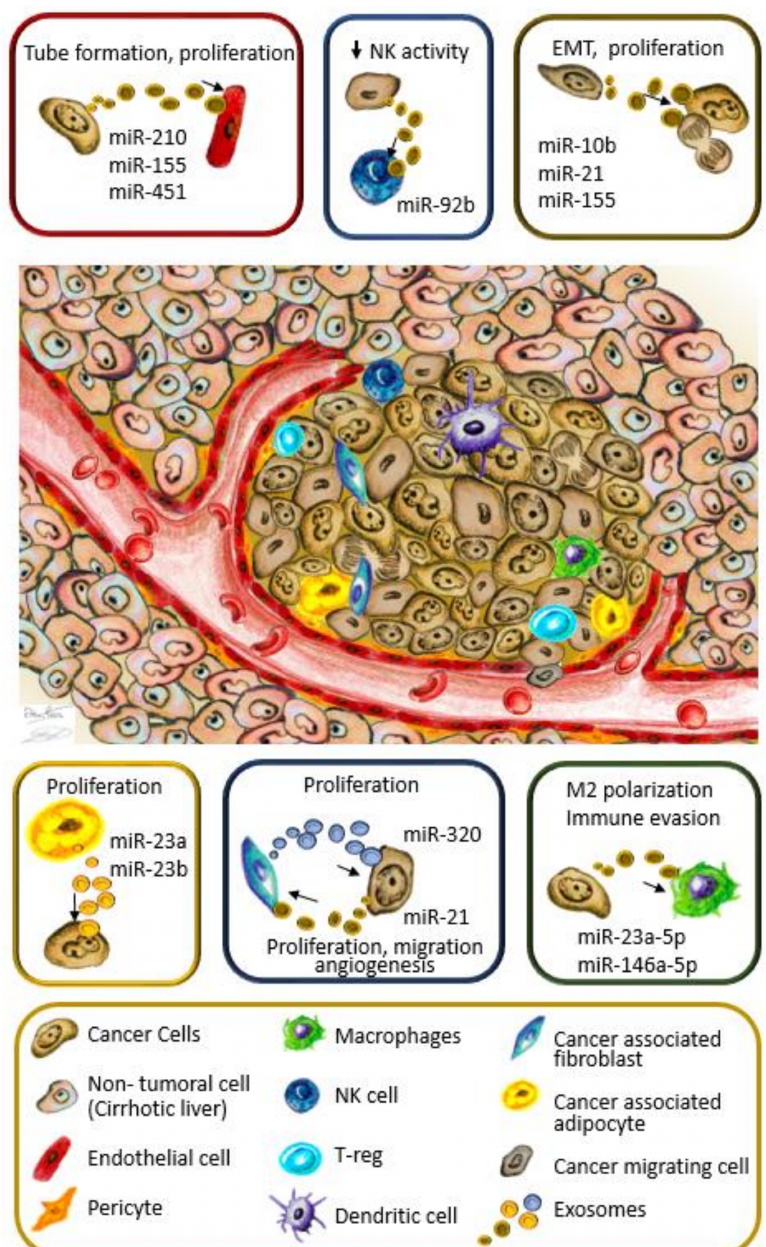
Figure 1. Intercellular communication in the tumor microenvironment. Di ff erent cell types reside within the tumor microenvironment (TME), infiltrating immune cells, both from innate and acquired immunity, cancer-associated fibroblasts (CAFs), cancer-associated adipocytes, and cells constituting tumor vessels. All these cells cooperate in a complex regulatory network fostering tumor establishment, growth, and metastasis, in which exosomal microRNAs (miRNAs) are emerging as relevant players in cell-to-cell communication. In colored boxes are the exosomal-miRNA exchanges between cells of the TME. The absence of miR-451 and miR-320 in exosomes fosters tumor growth, as described in the text. NK, Natural killer Cells; T-reg, Regulatory T